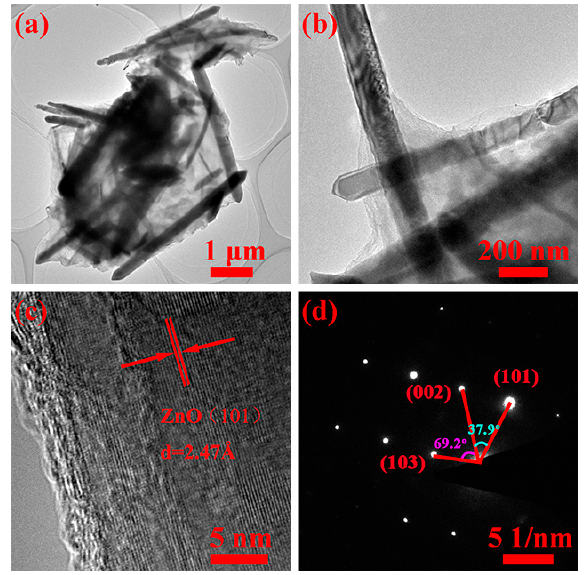
Figure 4. TEM images of ( a , b ) ZnO/graphene composites and ( c ) a single ZnO nanoparticle; ( d ) selected area electron diffraction (SAED) pattern of ZnO.